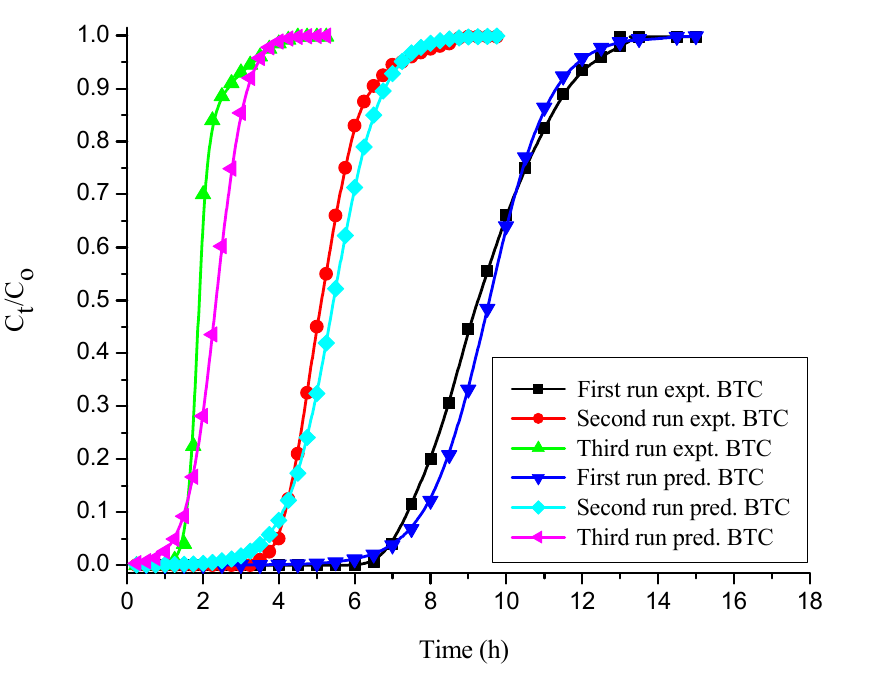
Figure 7. BTCs for experimental vs. simulated Thomas model for the decolorization of CR by sodium silicate gel-immobilized NNLP adsorbent in various runs. (Initial pH: 6; flow rate: 1 mL min − 1 ; inlet dye concentration: 15 mg L − 1 ; temperature: 301 K)